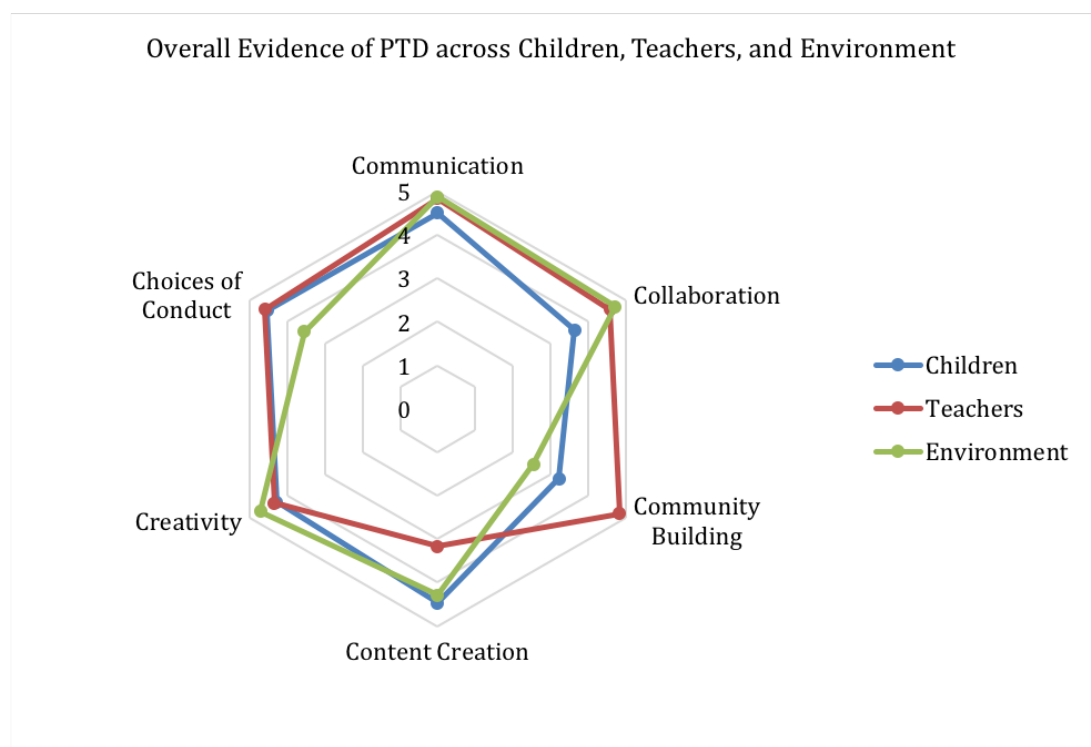
Figure 12. This chart represents relationships among children, teachers, and the environment across all dimentions of